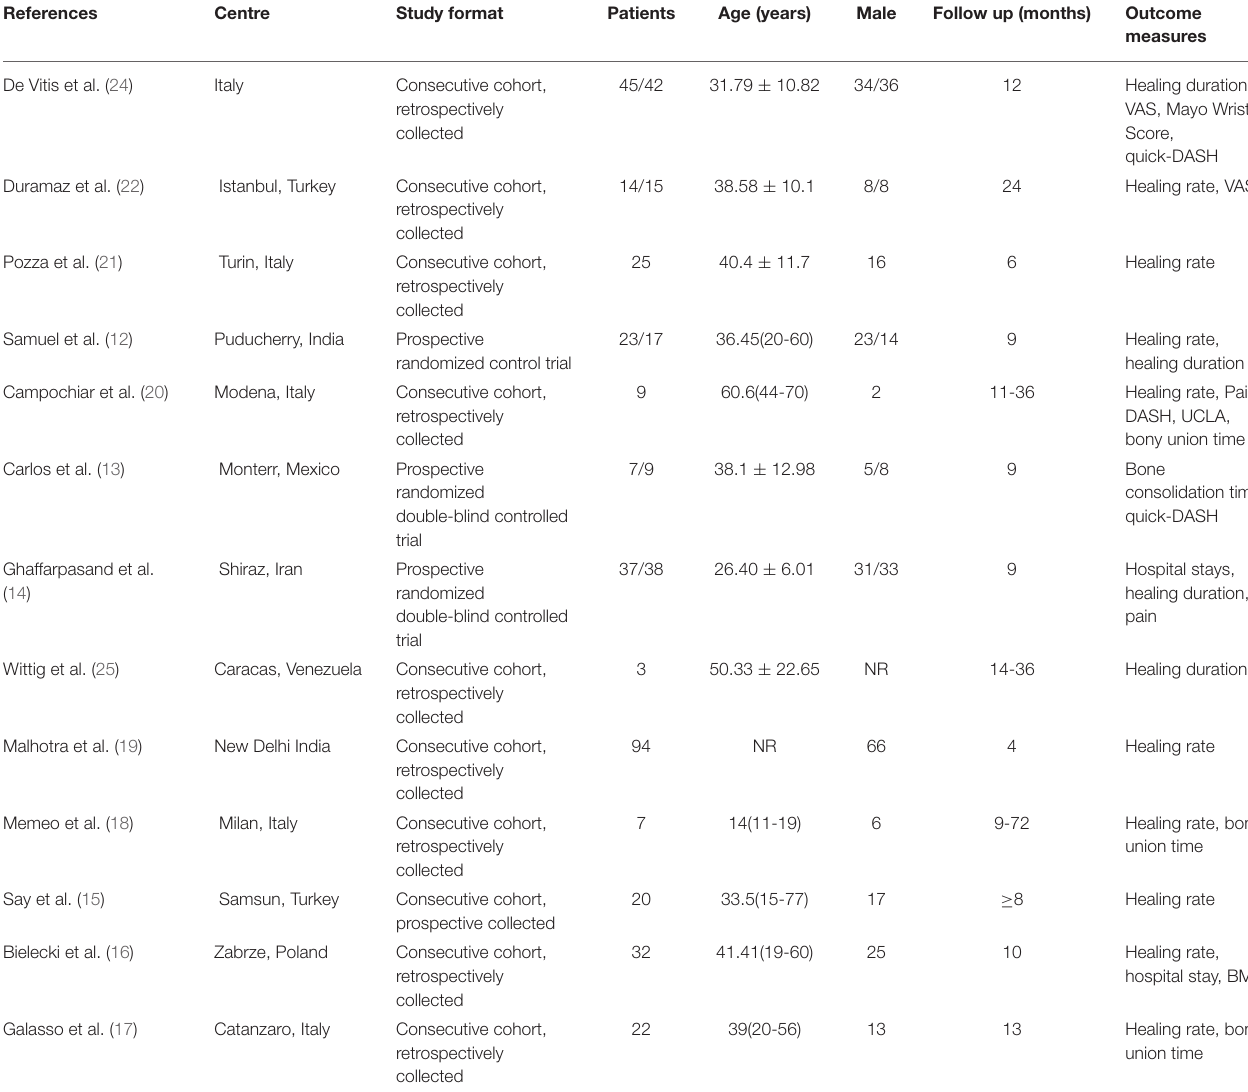
TABLE 1 | An overview of the included